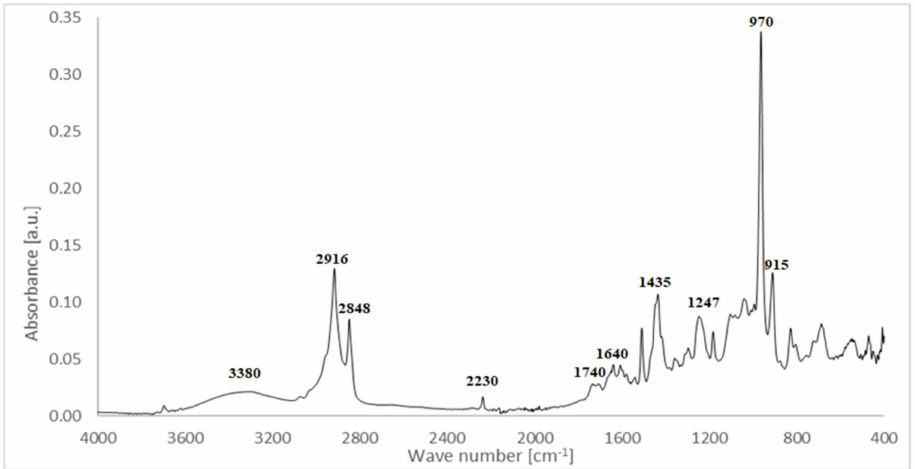
Figure 9. FTIR spectrum of NBR crosslinked with PO resin